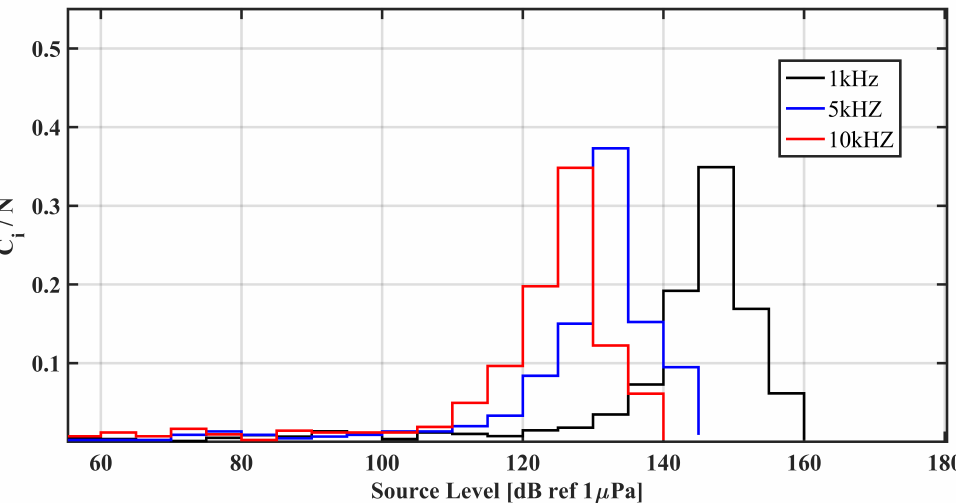
Figure 1. Distribution of the source level values associated with the ships accounted for in the assessment. Randi model has been applied on the 2019 AIS data. C i represents the samples included in a frequency bin, and N is the total number of